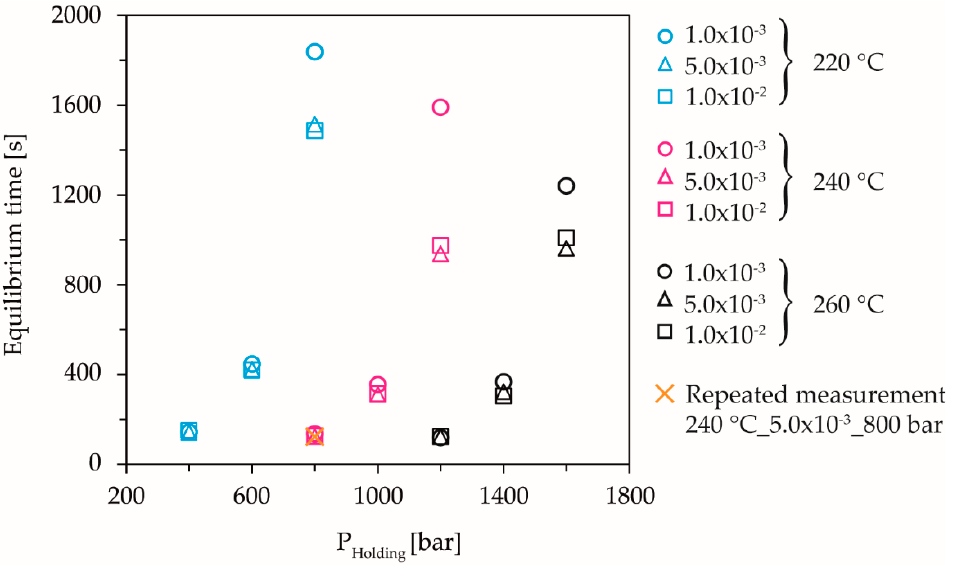
Figure 7. Measured equilibrium time as a function of holding pressure, temperature, and compression rate.